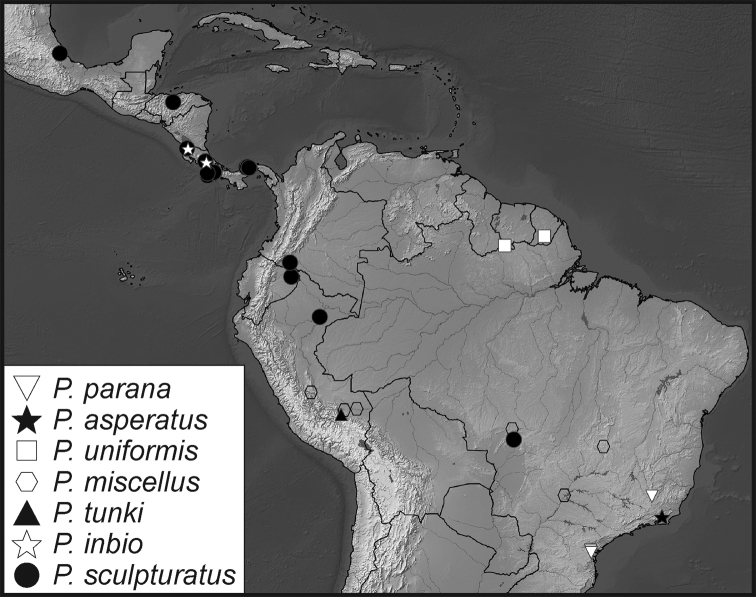
Collecting records for Phelister
parana (inverted triangles), P.
asperatus (black stars), P.
uniformis (white squares), P.
miscellus (white hexagons) P.
sculpturatus (black circles), P.
inbio (white stars) and P.
tunki (black upright triangle).